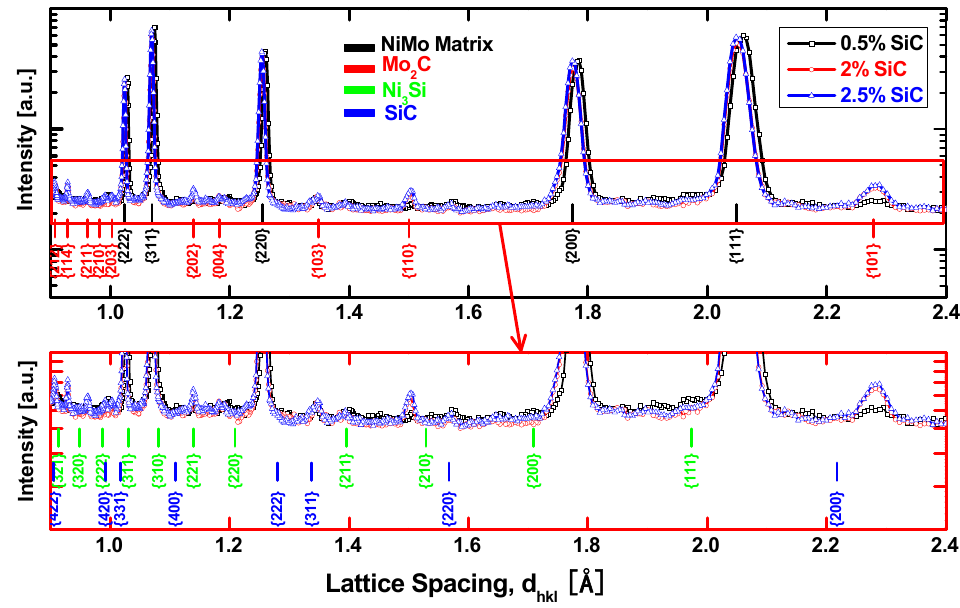
Figure 5. Neutron diffractograms of 48-h-milled NiMo-SiC DPS alloys with an increasing amount of SiC in the initial powder mixture.